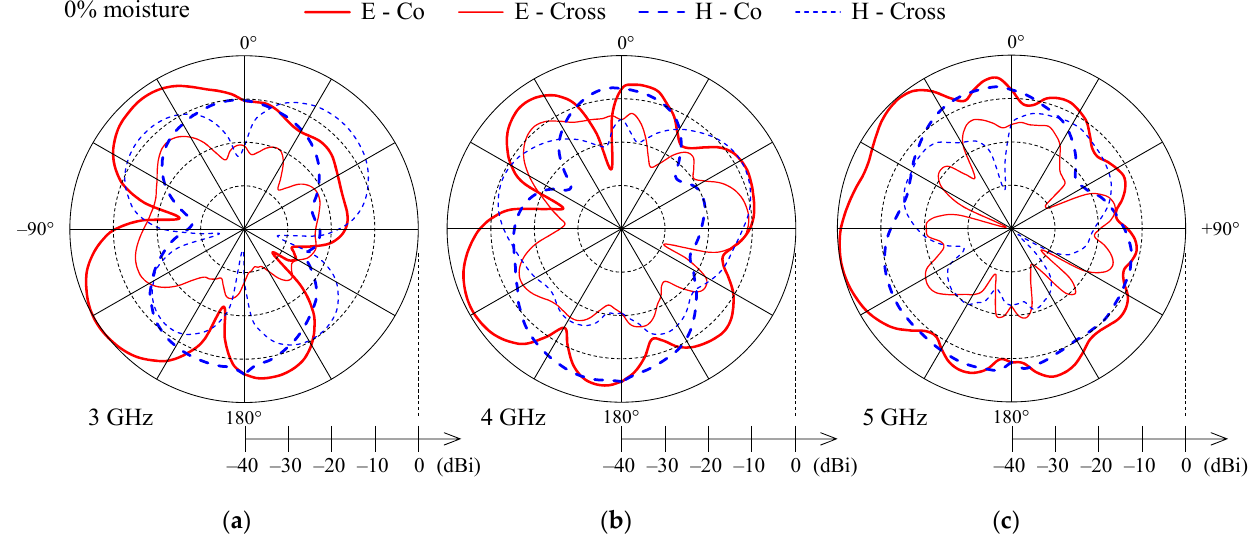
Figure 10. Measured co-polarization (thick line) and cross-polarization (thin line) gain patterns in E-plane (solid) and H-plane (dashed) for the wideband textile monopole with 0% moisture content at ( a ) 3 GHz, ( b ) 4 GHz, and ( c ) 5 GHz.